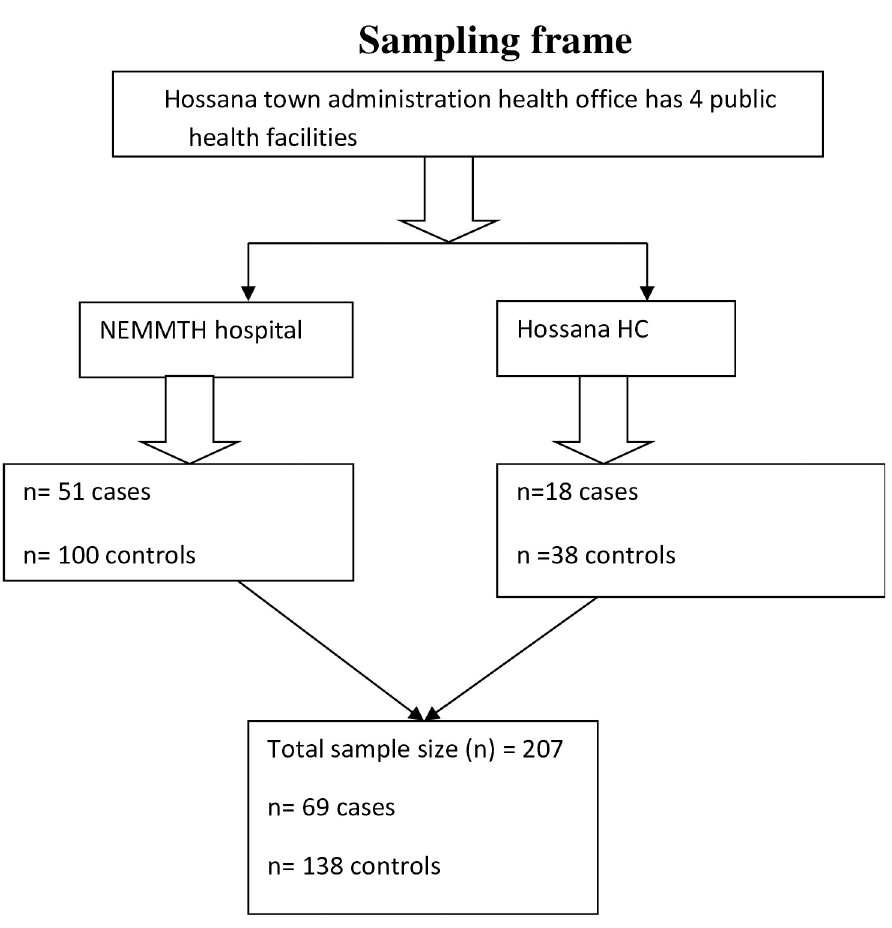
Fig 2. Sampling procedure scheme of mother who gave birth in public health facility, Hossana town administrative, Southern Ethiopia, 2018. HC: health centre, NEMMTH: Nigest Eleni Mohomod Memorial Teaching Hospital, n: proportional allocated sample